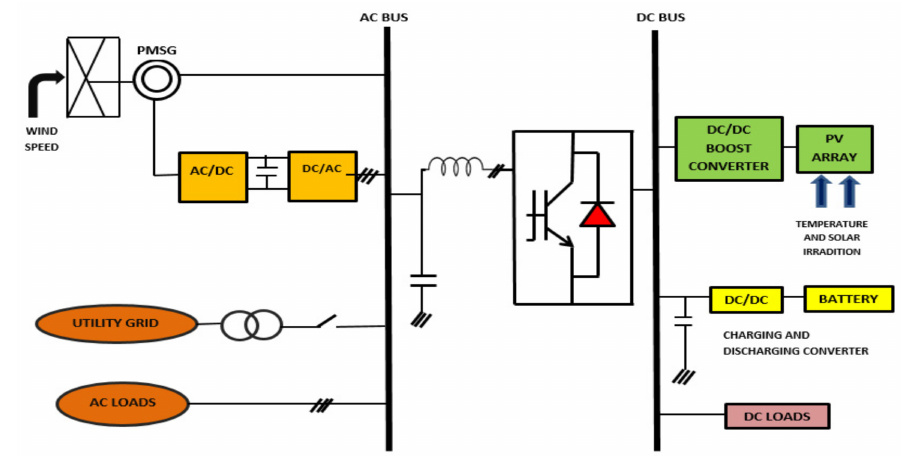
Figure 2. Typical hybrid AC / DC